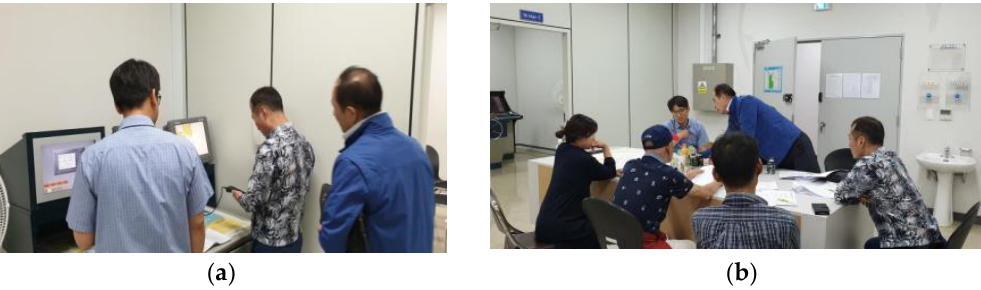
Figure A13. ( a ) User test; ( b ) discussion after the test.